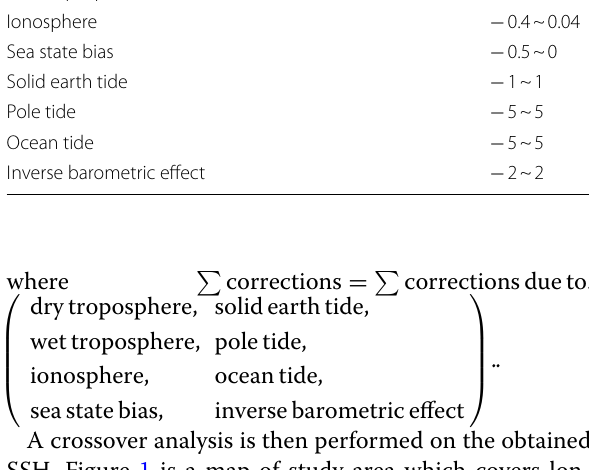
SSH. Figure 1 is a map of study area which covers lon- gitude 15° W to 5° E, and from latitude 4° S to 4° N. The region stretches from the continental shelve of Liberia in West Africa to the central African country of Gabon.